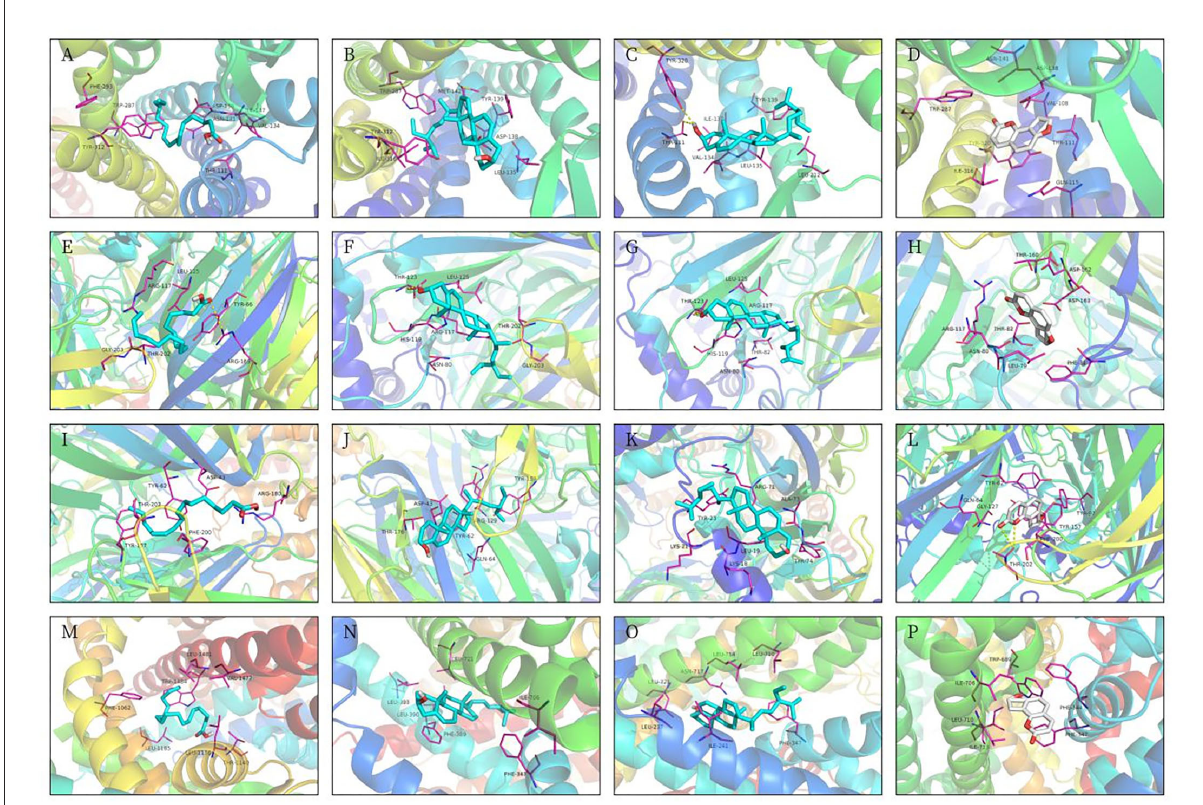
FIGURE7 Molecular docking 3D models. (A) OPRK1-hexadecanoic acid complex. (B) OPRK1-stigmasterol complex. (C) OPRK1-beta-sitosterol complex. (D) OPRK1-angelicin complex. (E) GABRA5-Hexadecanoic acid complex. (F) GABRA5-stigmasterol complex. (G) GABRA5-beta-sitosterol complex. (H) GABRA5-angelicin complex. (I) GABRP-hexadecanoic acid complex. (J) GABRP-stigmasterol complex. (K) GABRP-beta-sitosterol complex. (L) GABRP-angelicin complex. (M) SCN3B-Hexadecanoic acid complex. (N) SCN3B-stigmasterol complex. (O) SCN3B-beta-sitosterol complex. (P) SCN3B-angelicin